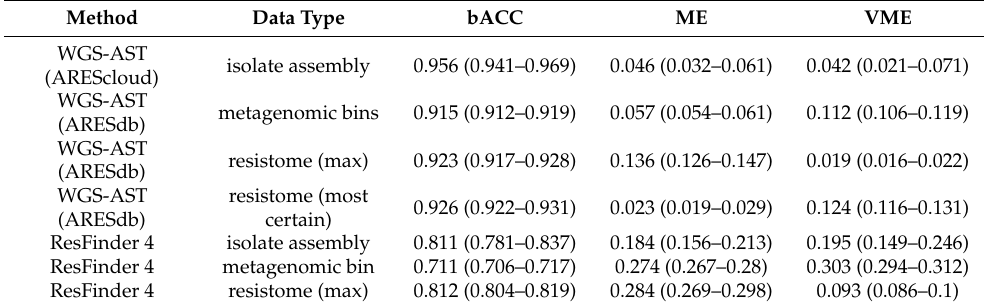
Table 1. Summary statistics of genomic AST methods applied to simulated short-read metagenomes derived from data published in [10]. Performance metrics for metagenomic bins and isolate assem- blies are aggregated over all short-read experiments (male and female E. coli mono-infection, K. pneumoniae/E. coli co-infection, K. pneumoniae/A. baumannii co-infection, and three-species co-infection) and 5 assayed antibiotic compounds. Metrics for resistomes are aggregated over resistome predictions as above and were scored against the true resistome as defined by the AST status of genomes used in the metagenome’s simulation. Values in brackets indicate 95% CI obtained by 1000 ×